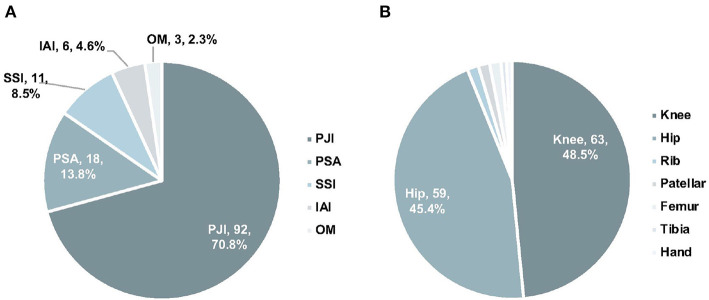
The distribution of infection types (A) and anatomic collection sites (B). PJI, prosthetic joint infection; IAI, implant-associated infection; SSI, surgical site infection; PSA, primary septic arthritis; MTCP, mycobacterium tuberculosis complex.